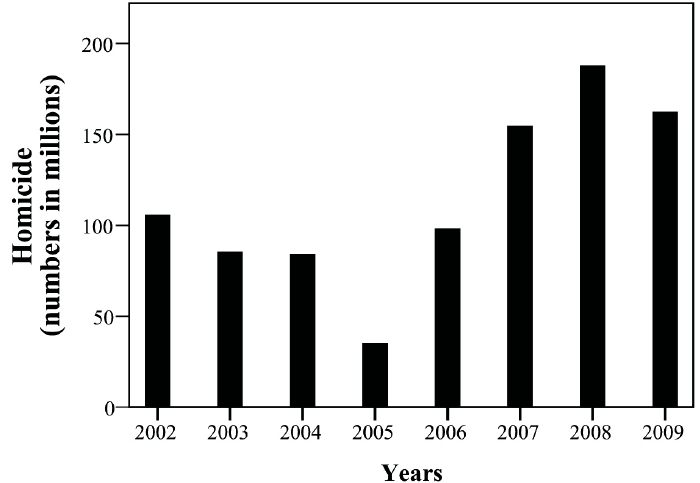
Figure 2. The temporal change of falls between 2002 and 2009.